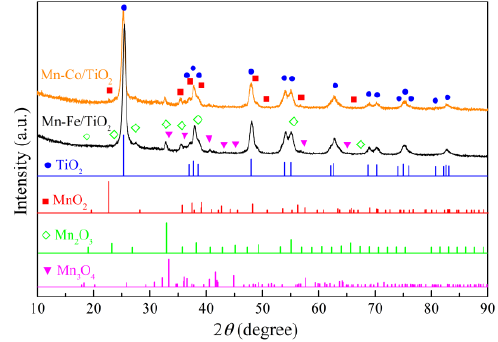
Figure 2. XRD patterns of Mn − Co/TiO 2 and Mn − Fe/TiO 2 nanocatalysts.